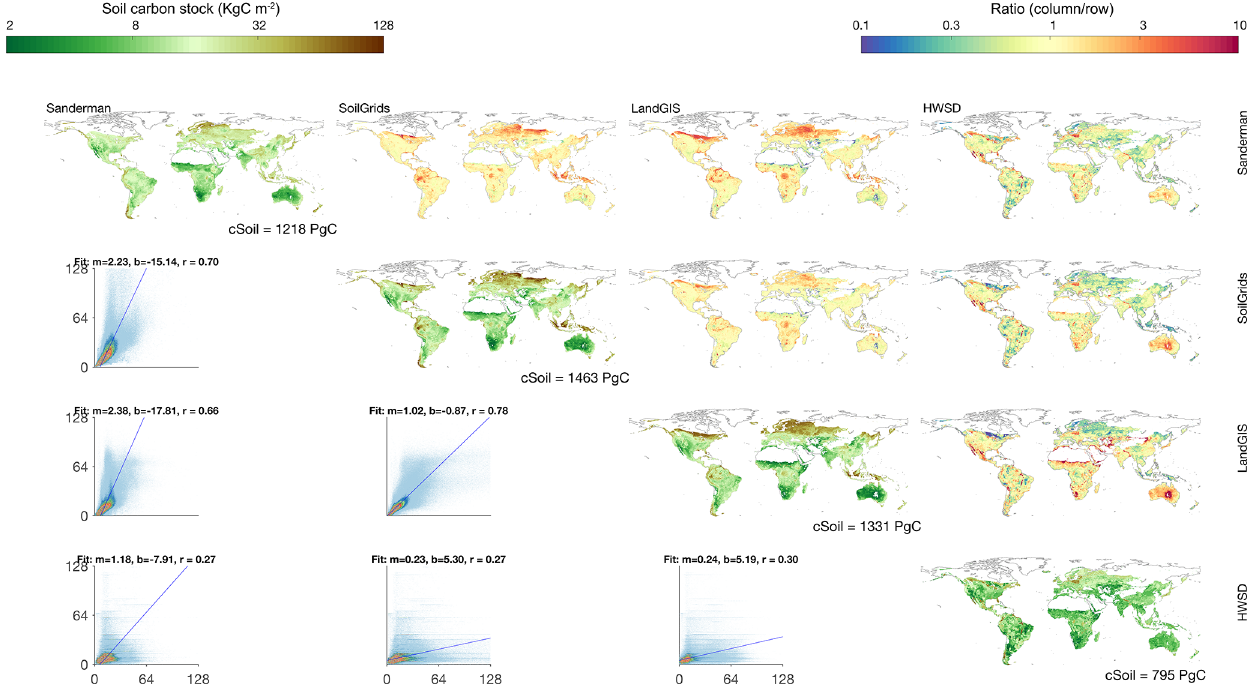
Figure 1. Spatial distributions of soil carbon storage at 0–100cm in the non-circumpolar regions. The total amount of carbon stock is shown in the bottom of each diagonal panel. The upper off-diagonal panels show the ratios between each pair of datasets (column/row). The bottom off-diagonal panels show the density plots and major axis regression line between each pair of datasets ( m : slope, b : intercept, r : correlation coefficient). The ranges of both of the color bars approximately span between the 1st and the 99th percentiles of the data. Hereafter, all figures comparing different spatial maps include the information in a similar